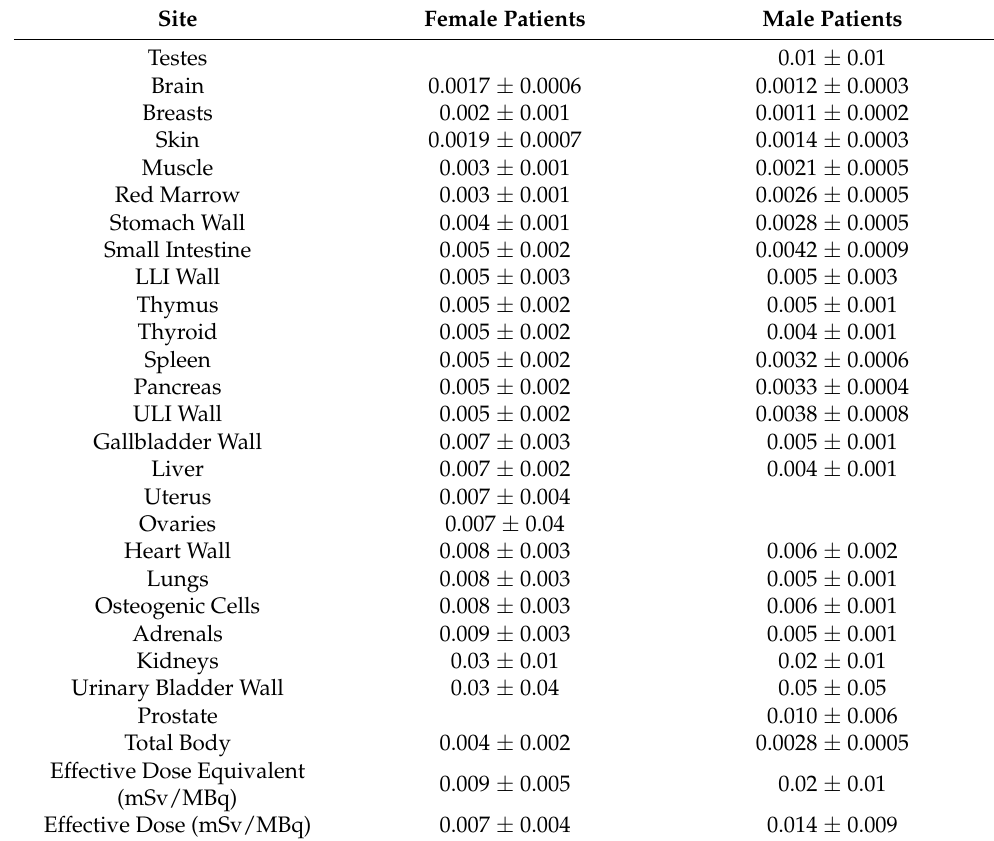
Table 3. Absorbed doses (mGy/MBq) after injection of [ 99m